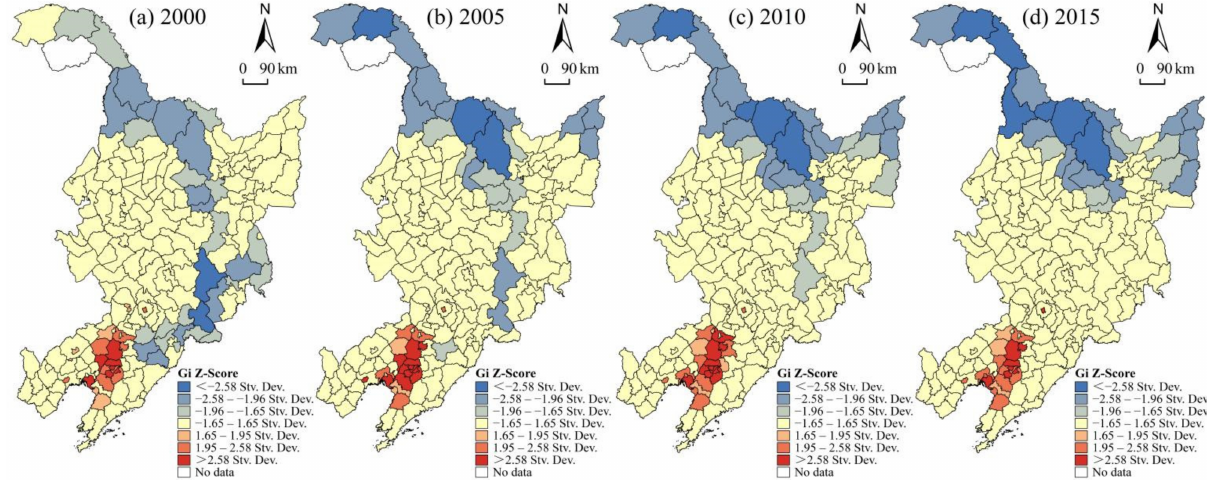
Figure 5. Distribution of cold and hot spots of TSDI in Northeast China for the years ( a ) 2000; ( b ) 2005; ( c ) 2010; ( d ) 2015.